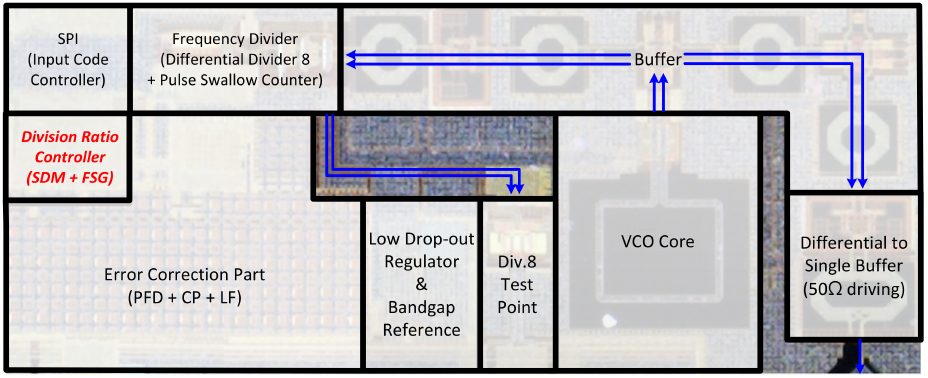
Figure 20. Photograph of the proposed dual-mode